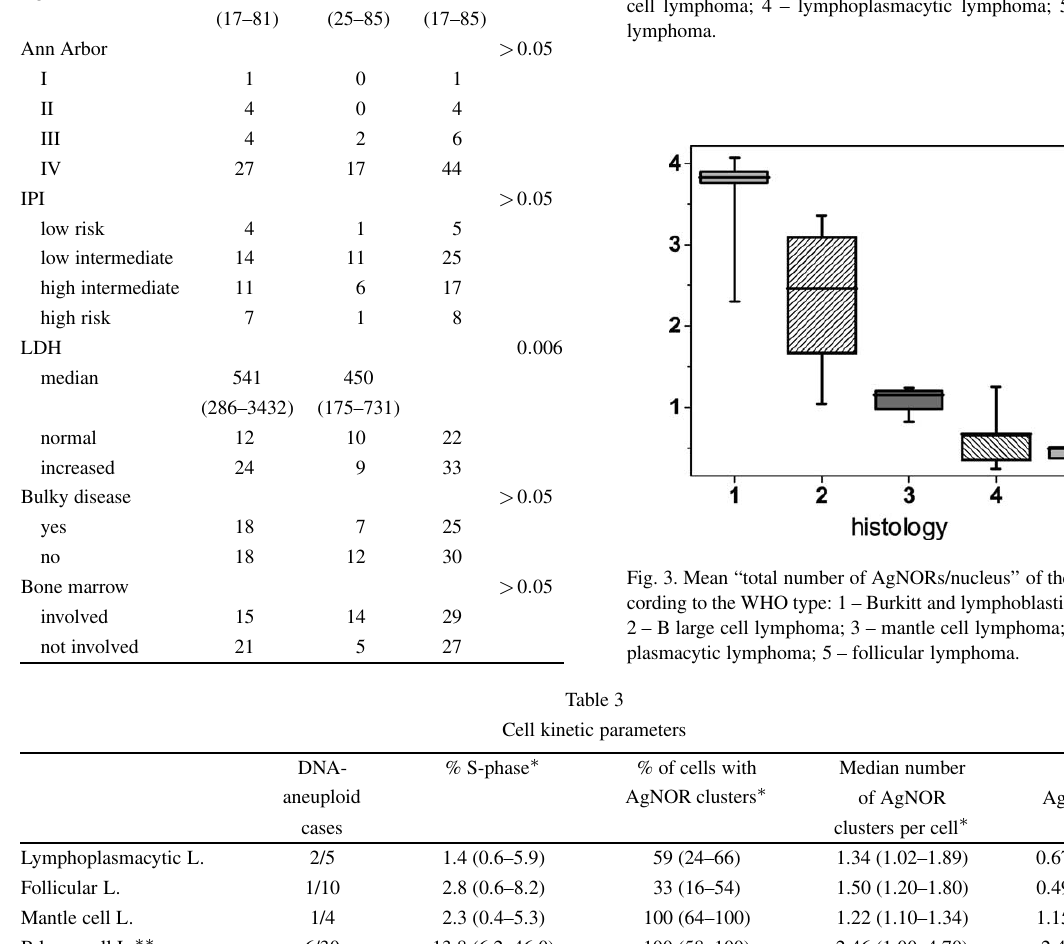
Fig. 2. SPF of the patients according to the WHO type: 1 – Burkitt and lymphoblastic lymphoma; 2 – B large cell lymphoma; 3 – mantle